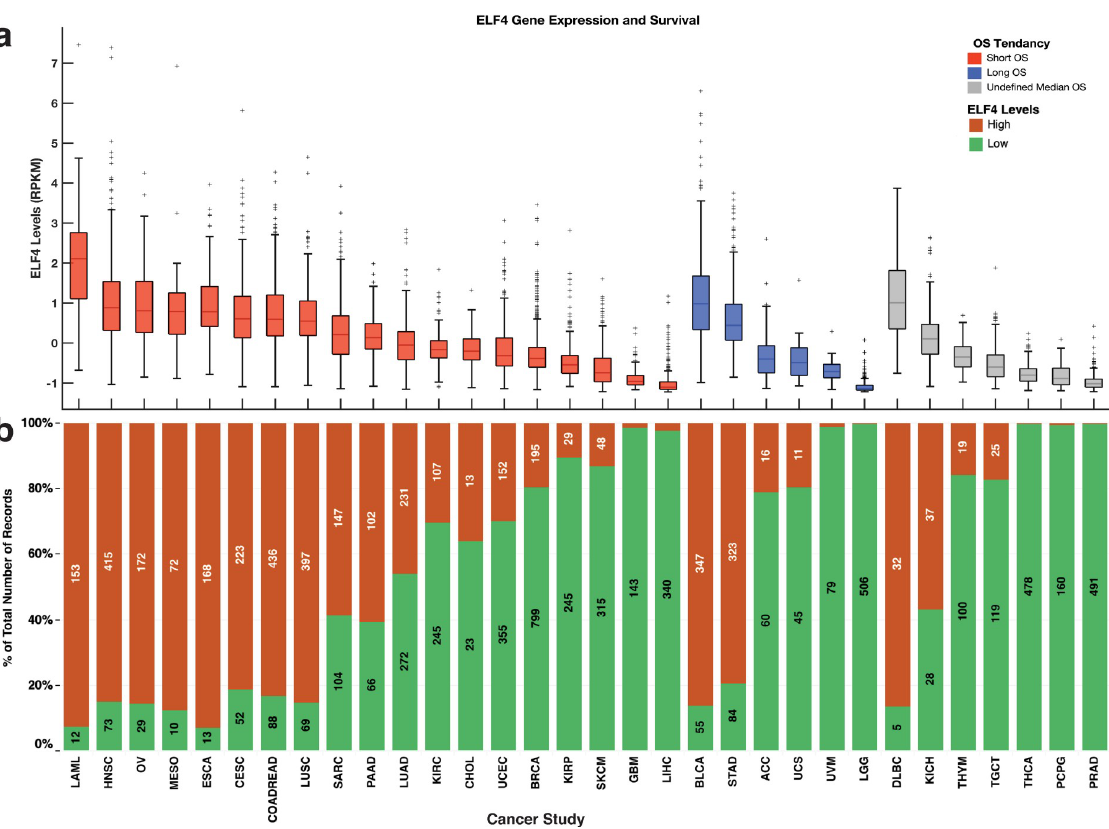
Fig 2. (a) Overall survival comparison within cancer types between patients afflicted with high-ELF4 tumours and those afflicted with low- ELF4 tumours. Compared to the patients with low-ELF4 tumours, the red boxplots indicate median OS durations that are shorter for the patients with high-ELF4 tumours; the blue indicates median OS durations that are longer for the patients with high-ELF4 whereas the grey boxplots indicate median OS periods that are undefined (undefined median DFS period in that > 50% of patients survived beyond the study duration). On each box, the centre mark shows the median, and the left and right edges of the box show the 25th and 75th percentiles, respectively. The whiskers extend to the most extreme data points that are not outliers, and the outliers are shown individually using the ’+’ symbol. (b) shows the percentage of the total number of patients with tumours with each group given the colours of the bars. The number of patients with tumours labels the marks expressed high ELF4 and low ELF4 transcripts. TCGA disease codes and abbreviations: UCEC, uterine corpus endometrial carcinoma; SKCM, skin cutaneous melanoma; BLCA, bladder urothelial carcinoma; UCS, uterine carcinosarcoma; OV, ovarian serous cystadenocarcinoma; LUSC, lung squamous cell carcinoma; STAD, stomach adenocarcinoma; LUAD, lung adenocarcinoma; ESCA, oesophageal adenocarcinoma; DLBC, diffuse large b-cell lymphoma; CESC, cervical squamous cell carcinoma; HNSC, head and neck squamous cell carcinoma; SARC, sarcoma; LIHC, liver hepatocellular carcinoma; BRCA, breast invasive carcinoma; COADREAD, colorectal adenocarcinoma; CHOL, cholangiocarcinoma; ACC, adrenocortical carcinoma; PAAD, pancreatic adenocarcinoma; PRAD, prostate adenocarcinoma; GBM, glioblastoma multiforme; KIRP, kidney renal papillary cell carcinoma; KIRC, kidney renal clear cell carcinoma; MESO, mesothelioma; LGG, brain lower grade glioma; UVM, uveal melanoma; PCPG, pheochromocytoma and paraganglioma; TGCT, testicular germ cell tumours; KICH, kidney chromophobe; THYM, thymoma; LAML, acute myeloid leukaemia; THCA, thyroid